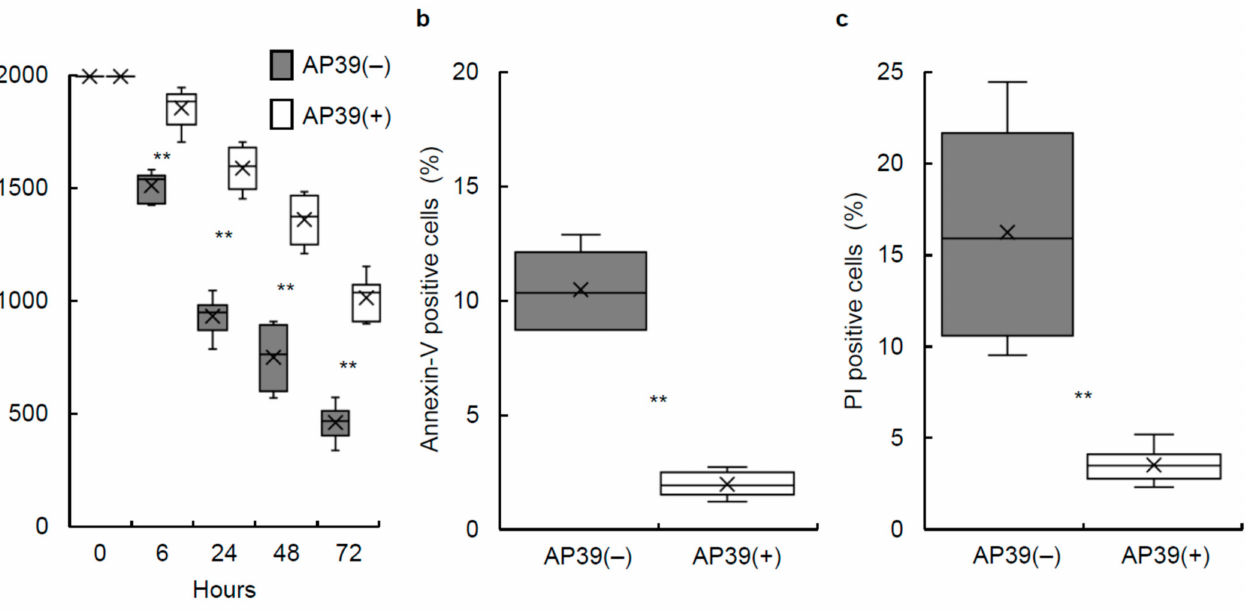
Figure 1. Culture of isolated islets with AP39. ( a ) Culture of isolated islets without AP39. Porcine islets were incubated without AP39 at 37 ◦ C for 24 h. ( b ) Culture of isolated islets with AP39. Porcine islets were incubated with 400 nM AP39 at 37 ◦ C for 24 h. Scale bars = 200 µ m.